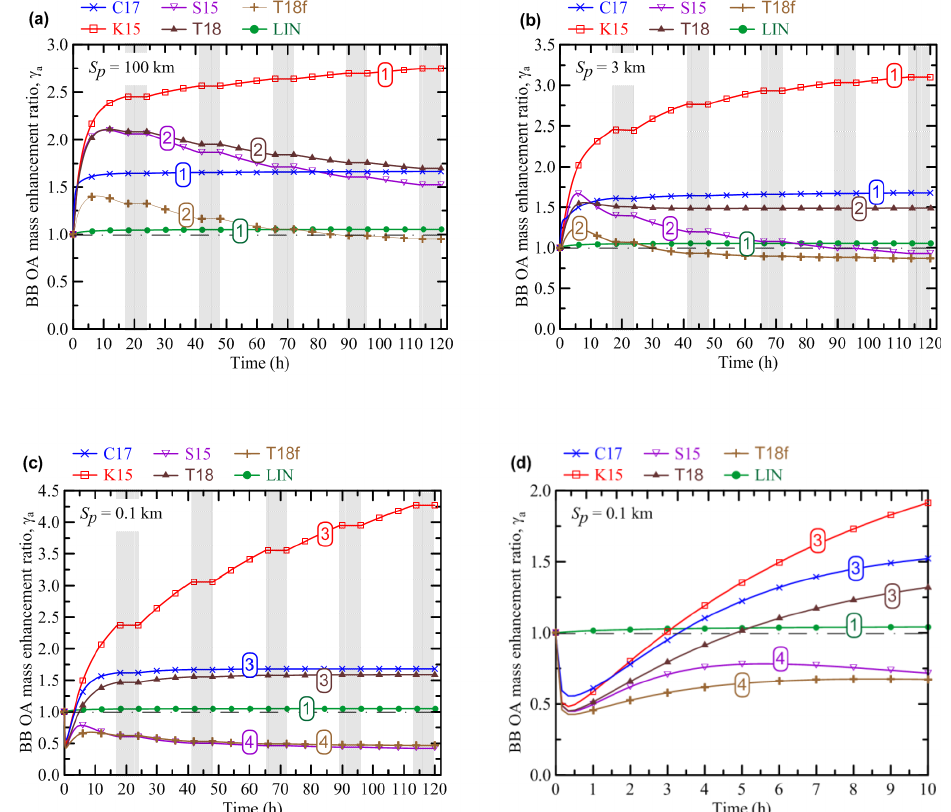
Figure 2. Evolution of the BB OA mass enhancement ratio ( γ a ) according to the simulations performed with the different OA schemes and with different values of the initial plume size: (a) S p = 100km, (b) S p = 3km, and (c, d) S p = 0 . 1km. The initial BB OA concentration, C 0 , was fixed at 10 3 µgm 3 in all the simulations. Panel (d) shows a zoomed fragment of the simulations presented in panel (c) . Shaded bands depict nighttime periods when no oxidation reactions were allowed to occur. The numbers on the curves denote the different dynamical regimes of BB OA evolution according to the definitions in Sect. 3.1. A horizontal dashed–dotted line in each panel indicates the situation where no BB OA mass enhancement occurs ( γ a =